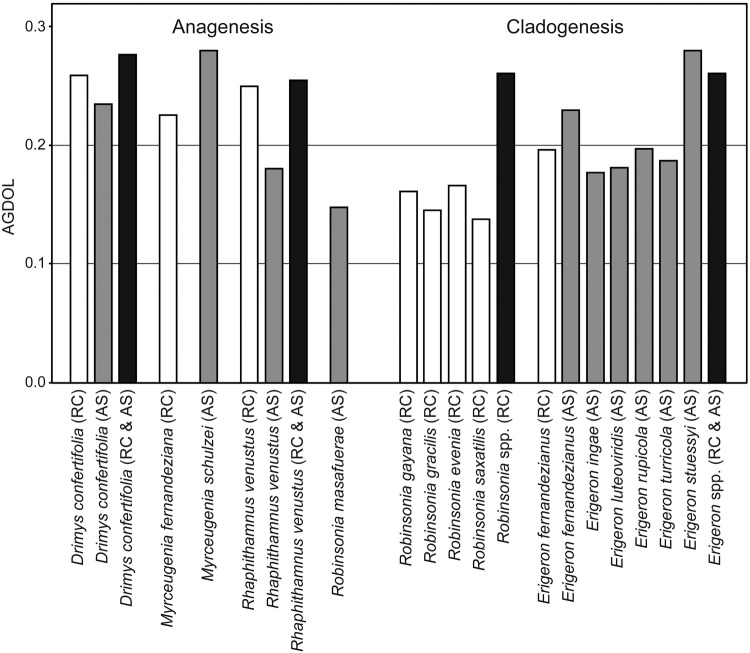
Summary of genetic diversities, AGDOL, within the endemic species of Drimys, Myrceugenia and Rhaphithamnus having originated by anagenesis, and Robinsonia and Erigeron having been derived through cladogenesis. Robinsonia masafuerae from the younger island is also an anagenetic derivative from the cladogenetic complex of Robinsonia on the older island. AS, Alejandro Selkirk Island; RC, Robinson Crusoe Island. White bar indicates an endemic species in RC, grey bar an endemic species in AS and black bar multiple species or islands combined.